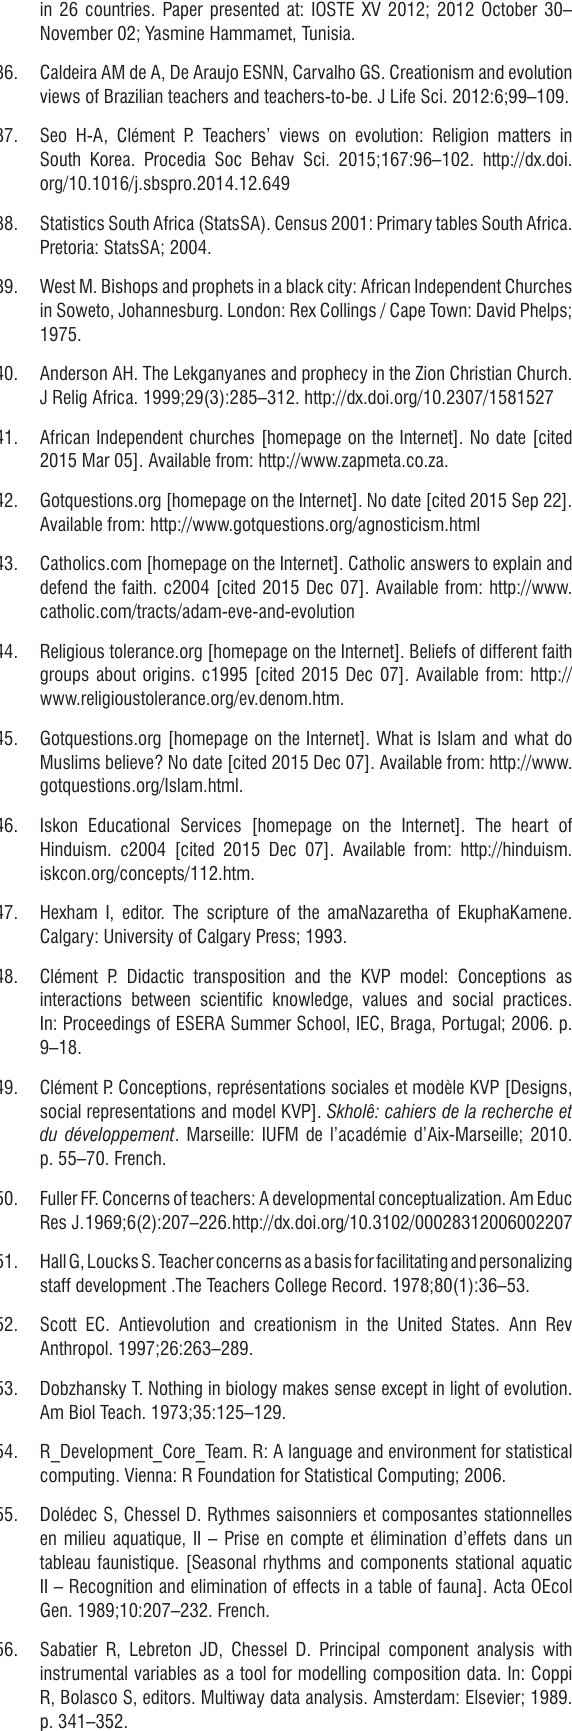
tableau faunistique. [Seasonal rhythms and components stational aquatic II – Recognition and elimination of effects in a table of fauna]. Acta OEcol Gen. 1989;10:207–232.